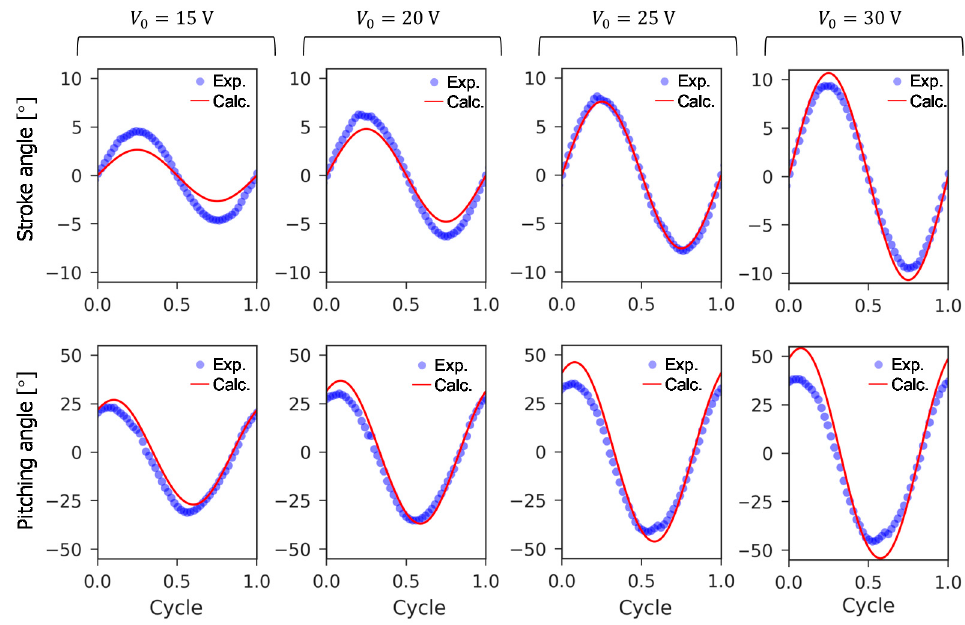
Figure 11. Measured and calculated stroke and pitching angle of small-type actuator: blue circle and red line show experimental data and calculated result, respectively.